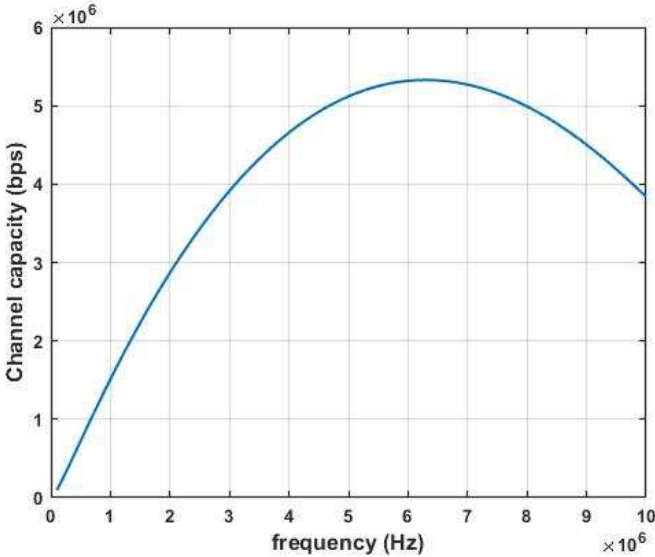
Figure 2. Channel capacity of subsea MI (magnetic-induction) wireless communications with transmission distance = 1 m and coil radius = 0:05